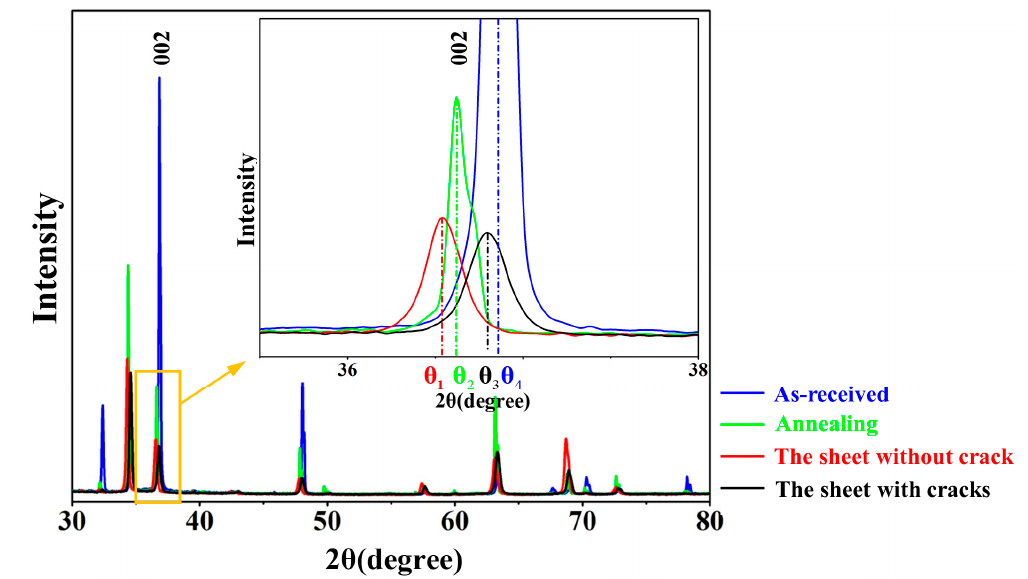
Figure 6. XRD spectra of the samples cut from the as-received sheet, the sheet without crack, the sheet with cracks, and the sheet without cracks after annealing for 180 °C, 2 h were compared.